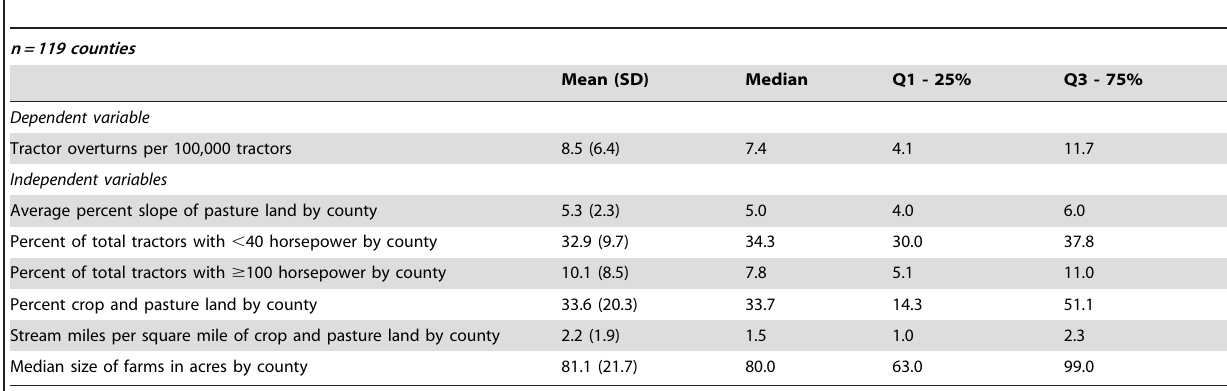
Table 3. Descriptive statistics of county level estimates of tractor overturn rates, tractor characteristics, and physiographic characteristics in